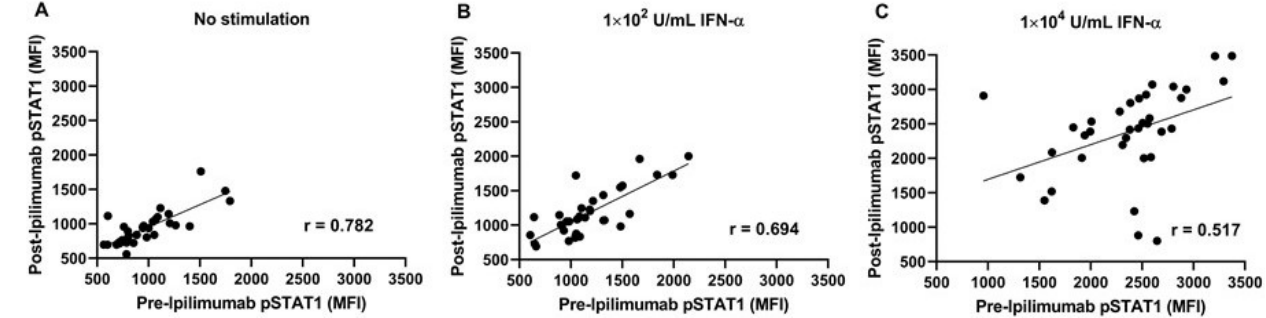
Figure 3. Intermediate interferon- α stimulation resulted in the correlative relationship of phosphor- ylated STAT1 (pSTAT1) levels pre- vs. post-ipilimumab treatment ( A ) Without interferon- α ; ( B ) with interferon- α stimulation, 10 2 U/mL; and ( C ) with interferon- α stimulation, 10 4 U/mL.